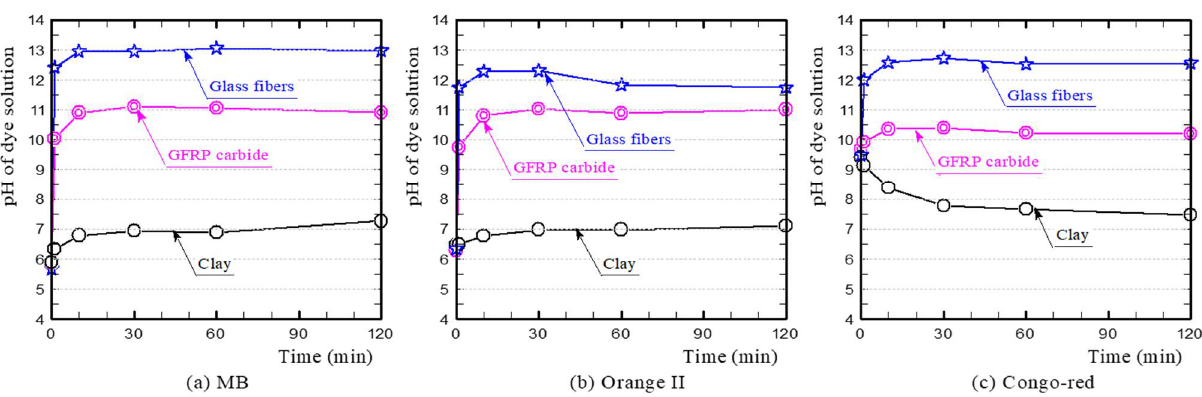
Figure 9. MB (a) , Orange II ( b ), Congo-red ( c ) dye concentration reduction rates of the GFRP carbides and glass fibers.